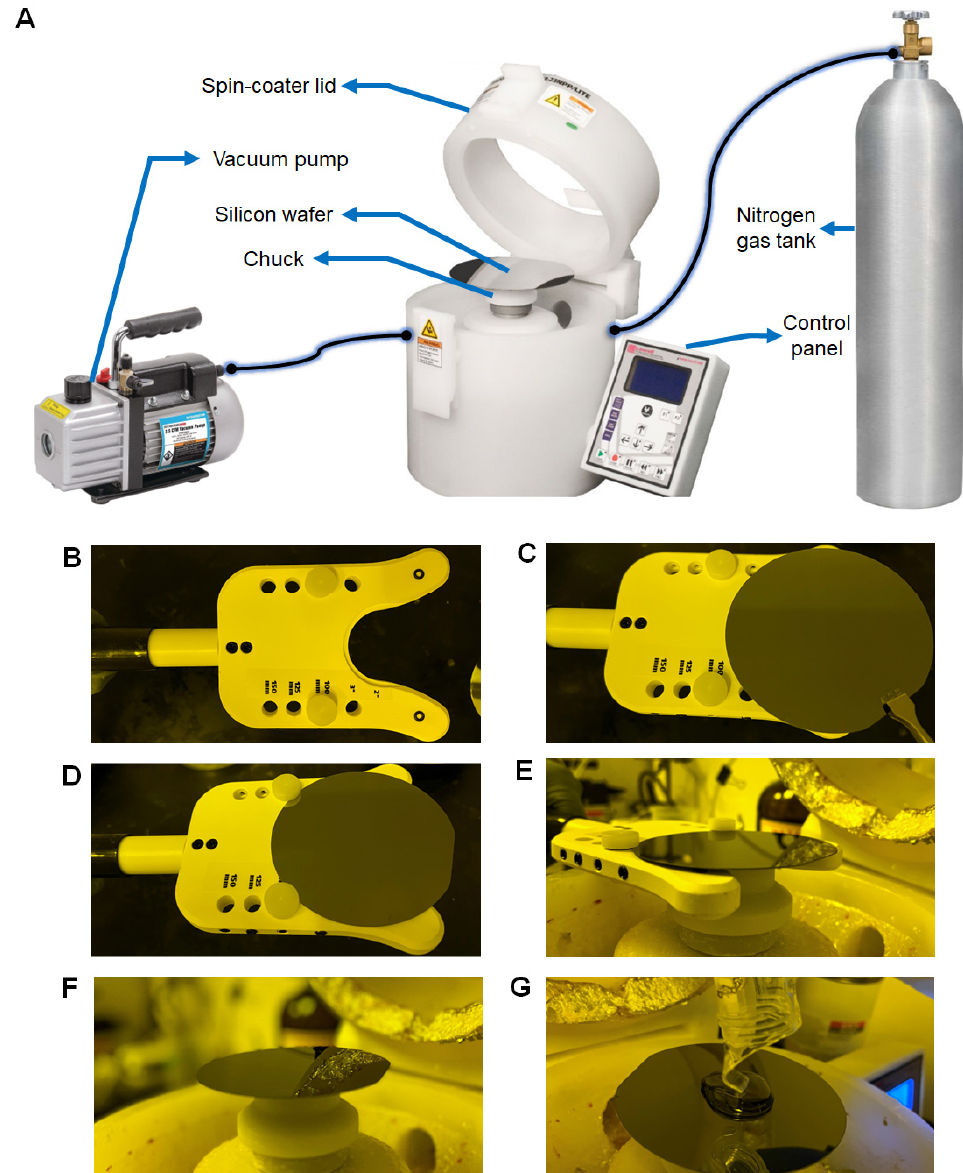
Figure 3. ( A ) Spin coater assembly—The spin coater is attached to a vacuum pump and a nitrogen gas tank using a proper tube and tube fittings. In addition, the control panel that comes with the spin coater is used to program the spin conditions, which helps evenly spread the SU-8 on the silicon wafer surface. ( B – G ) Handling and spin coating of the silicon wafer. ( B ) The plastic caps are set on 100 mm holes of the wafer alignment tool. ( C ) The silicon wafer is being put on the wafer holder with forceps. ( D ) The silicon wafer is snug fit into the plastic caps of the wafer holder. ( E ) The wafer holder is fit into the chuck and slowly lowered, which allows the silicon wafer to be positioned in the center of the chuck. ( F ) The abrasive surface of the silicon wafer is snug fit to the surface of the chuck due to vacuum. ( G ) Pouring SU-8 2100 on the center of the silicon wafer in a spiral formation avoiding the accumulation of